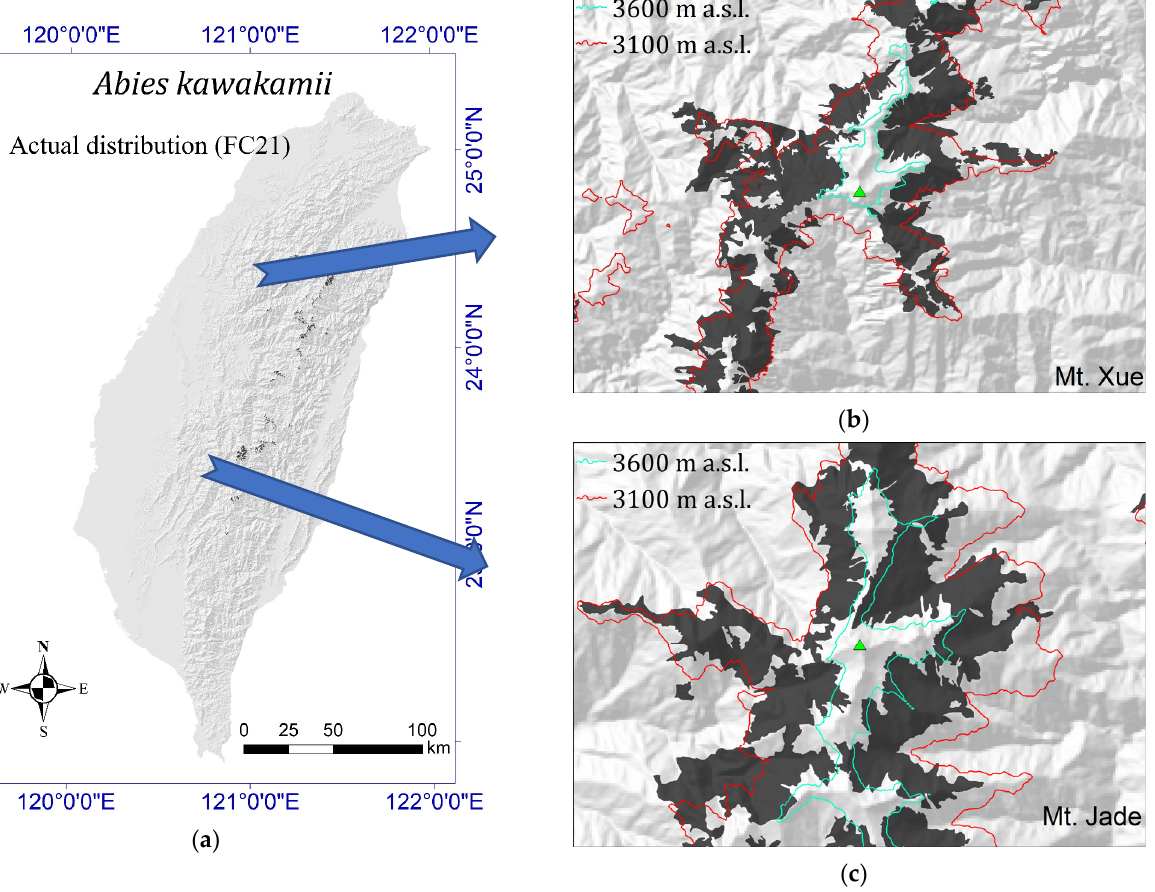
Figure 1. Actual distribution of Abies kawakamii (FC21 formation, black polygon) in Taiwan. Red line: 3100 m contour; blue line: 3600 m contour. ( a ) Taiwan island, ( b ) Mount Xue, and ( c ) Mount Jade.